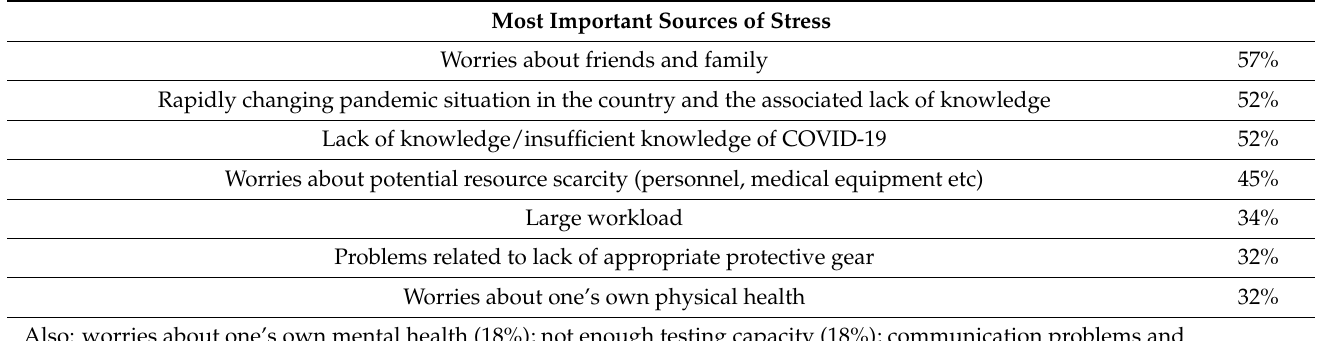
Table 5. Most important sources of stress during the 1st wave of pandemic (choice of up to 5). Most Important Sources of Stress Worries about friends and family 57%